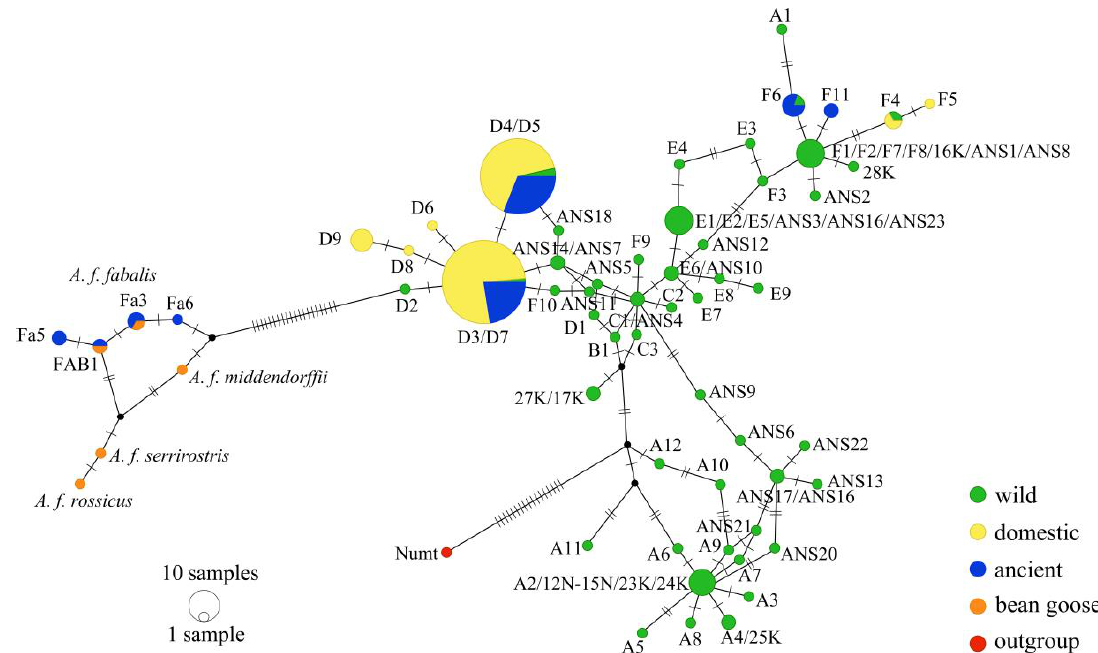
Figure 3. Median-joining haplotype network of the concatenated hypervariable part of the mitochondrial control region (204 bp) of subfossil goose samples (ancient), modern domestic goose samples (domestic), modern wild greylag goose Anser anser haplotypes (wild), bean goose Anser fabalis haplotypes (bean goose), and nuclear sequence of mitochondrial origin, Numt (outgroup) sequences. Forward slashes between haplotype names denote haplotypes that differ over the whole control region sequence (1249 bp) but cannot be distinguished in the 204 bp sequence analyzed here. Circle area is proportional to the frequency of each haplotype and mutational steps between the haplotypes are indicated by tick marks across branches.